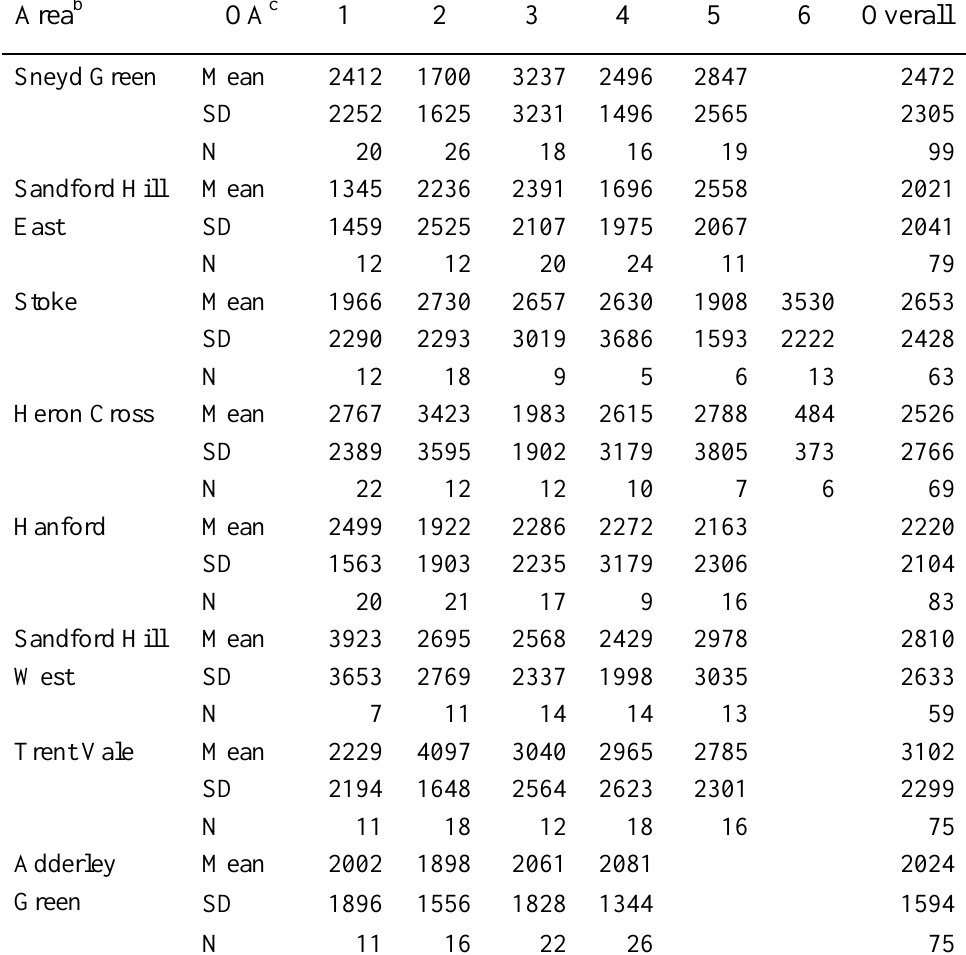
Table 3. Summary of physical activity outside of work (MET minutes/week) by census output area within study areas a